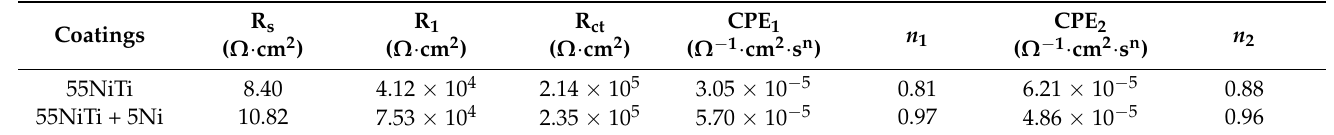
Table 6. Equivalent circuit parameters of the